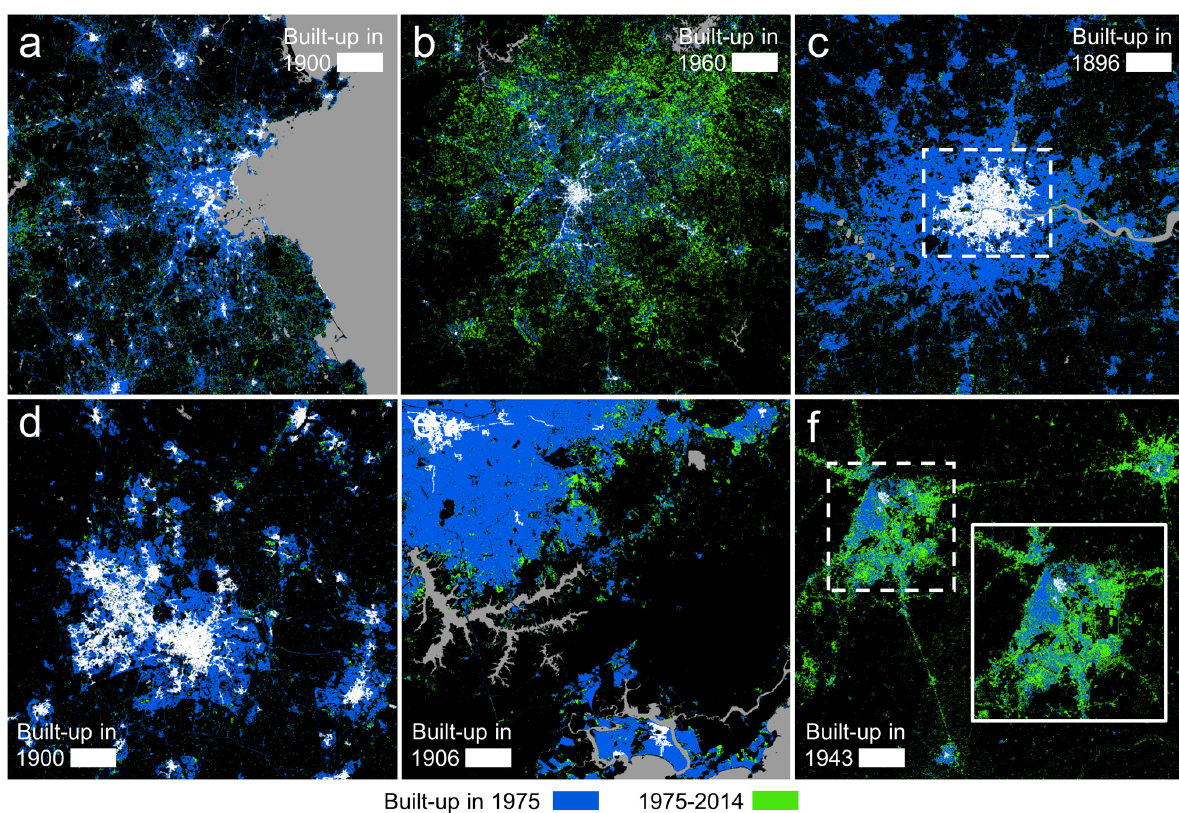
Figure 9. Extracted historical urban extents for all study areas. ( a ) Boston metro area, ( b ) Atlanta metro area, ( c ) London (dashed rectangle shows the study area extent), ( d ) Birmingham and surroundings, ( e ) south-east part of greater Sao Paulo area, and ( f ) Lahore-Amritsar area with an inset map of Lahore.